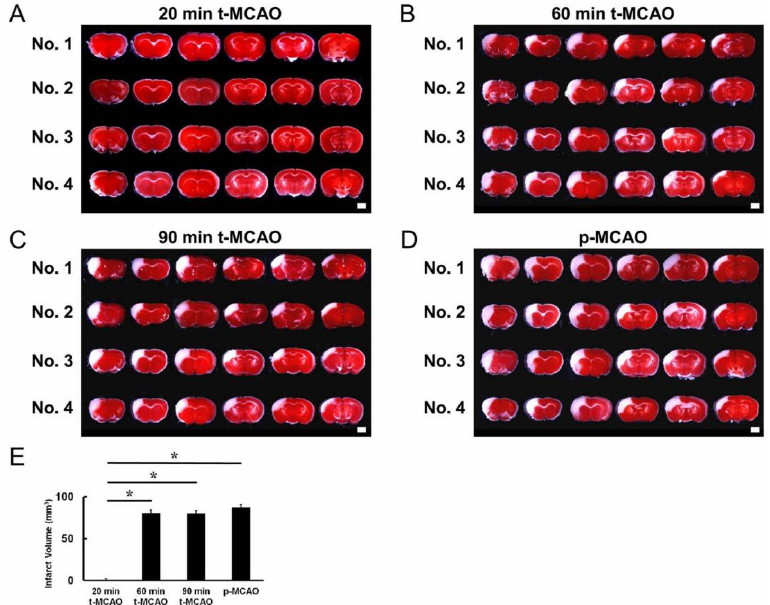
Figure 1. TTC staining at 1 d post stroke in four mice per condition (No. 1, 2, 3, 4). Following 20-min t-MCAO, partial ischemia was observed in 1/4 mice (No. 4) ( A ). In contrast, ischemia was observed in all mice after 60-min t-MCAO ( B ), 90-min t-MCAO ( C ), and p-MCAO ( D ). Compared to 20-min t-MCAO, infarct volume was significantly higher in mice after 60-min t-MCAO, 90-min t-MCAO, and p-MCAO, but not different between these groups ( E ). Scale bars = 2 mm ( A – D ). * p < 0.05 vs. 20 min t-MCAO ( E ) ( n = 4, for each group). Abbreviations: p-MCAO, permanent middle artery occlusion; t-MCAO, transient middle cerebral artery occlusion.